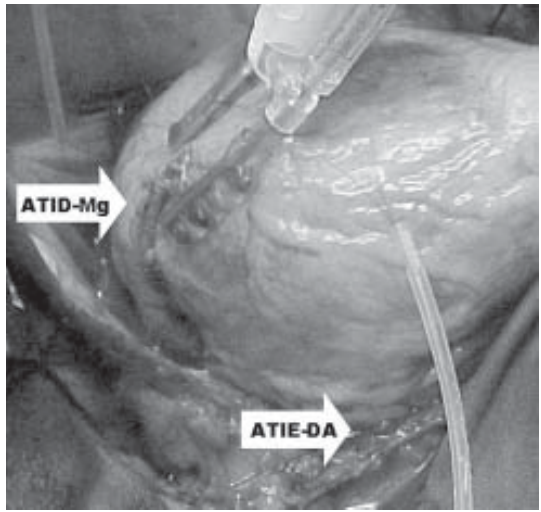
Fig. 1- Anastomose da artéria torácica interna direita (ATID) com a artéria marginal (Mg). Artéria torácica interna esquerda (ATIE) com a artéria coronária descendente anterior (DA).